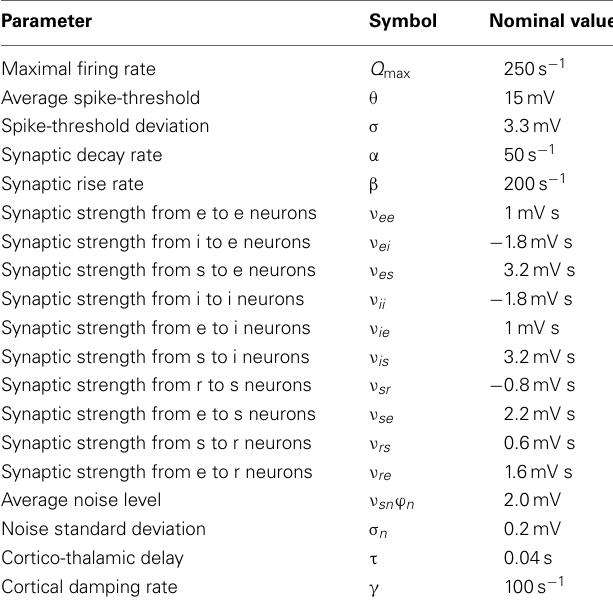
Table 1 | Model parameters, their symbols, and nominal